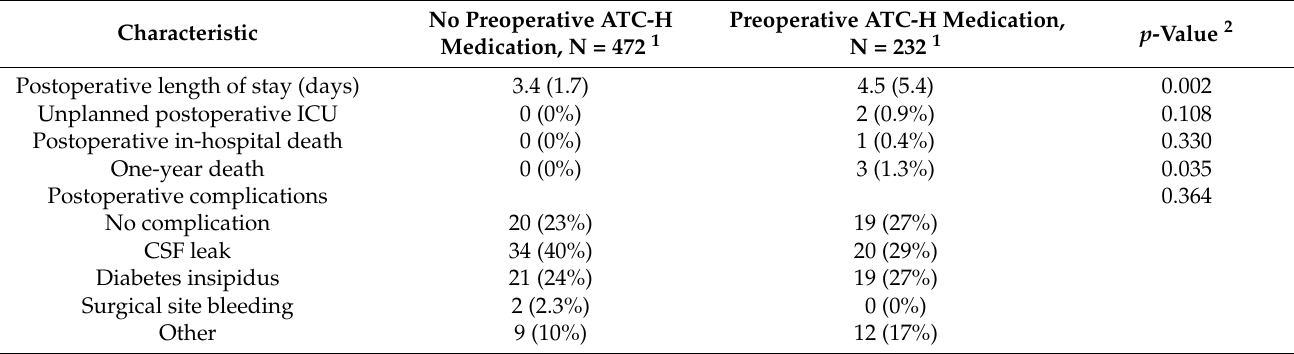
Table 3. Postoperative